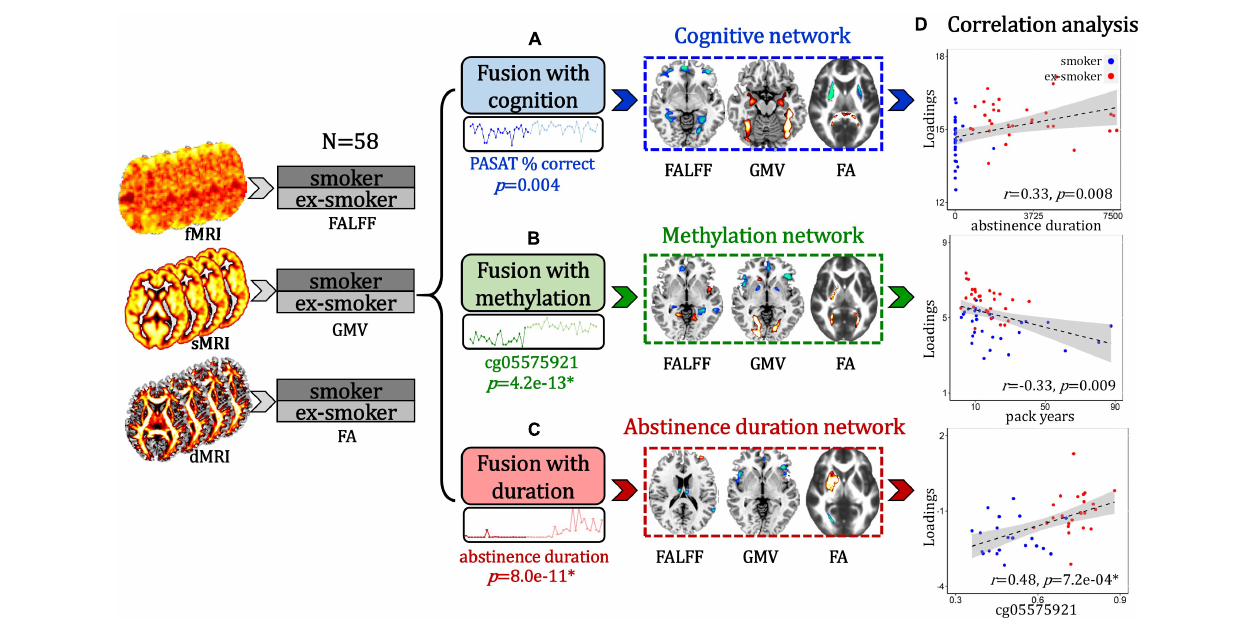
FIGURE 1 | Flow diagram of the study design. (A) Paced Auditory Serial Addition Test (PASAT)-guided fusion was performed on fALFF + GMV + FA to identify a smoker and ex-smoker group-discriminating multimodal brain network that associated with cognition. (B) cg05575921 loci methylation-guided fusion was used to identify a smoker and ex-smoker group-discriminating multimodal brain network that associated with DNA methylation. (C) Duration of the last quit attempt-guided fusion was used to identify an abstinence duration-associated multimodal brain network that discriminated between smokers and ex-smokers. (D) Correlation analyses were performed between these identified multimodal networks and smoking-related